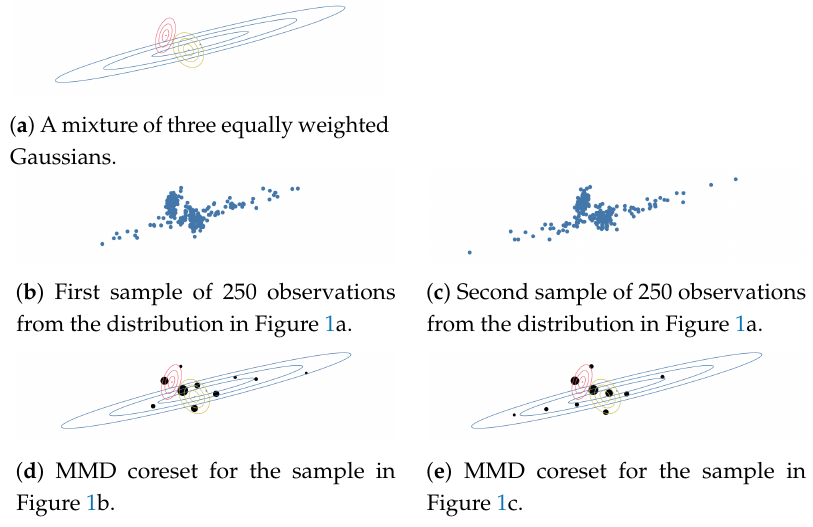
Figure 1. ( a ) Three equally weighted Gaussians (lines show 1, 2, 3 standard deviations of each component). ( b , c ) Independently sampled datasets from the mixture of three Gaussians. ( d , e ) MMD coresets for the three-Gaussian datasets.